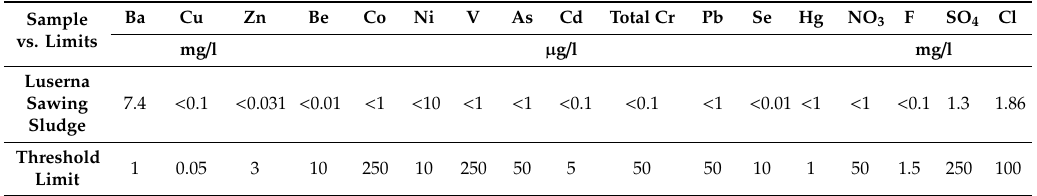
Table 2. Results of the leaching test performed according to M.D. 05_02_1998, appendix A of UNI 10802 standard and UNI EN 12457-2 standard. Last row: threshold limit of metal concentration, by Italian regulation.